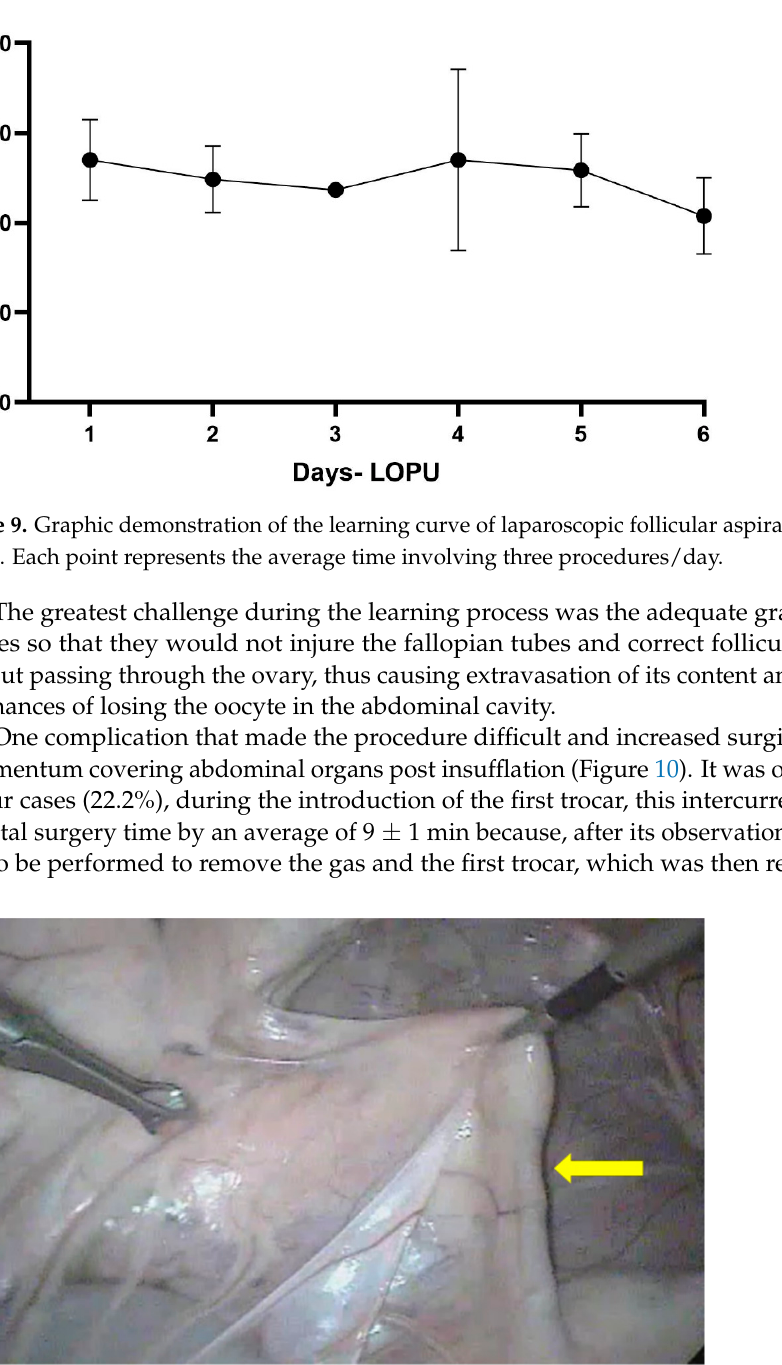
8 of 12 Figure 8. Laparoscopic view of the ovary of a buffalo calf submitted to follicular aspiration. Red arrow, atraumatic forceps; yellow arrow, aspiration needle. Discrete ovarian bleeding caused by follicular puncture was also recorded. However, this was controlled before the end of the LOPU procedure and before the final washing of the ovaries for clot removal, preventing adhesion formation. During repeated procedures,